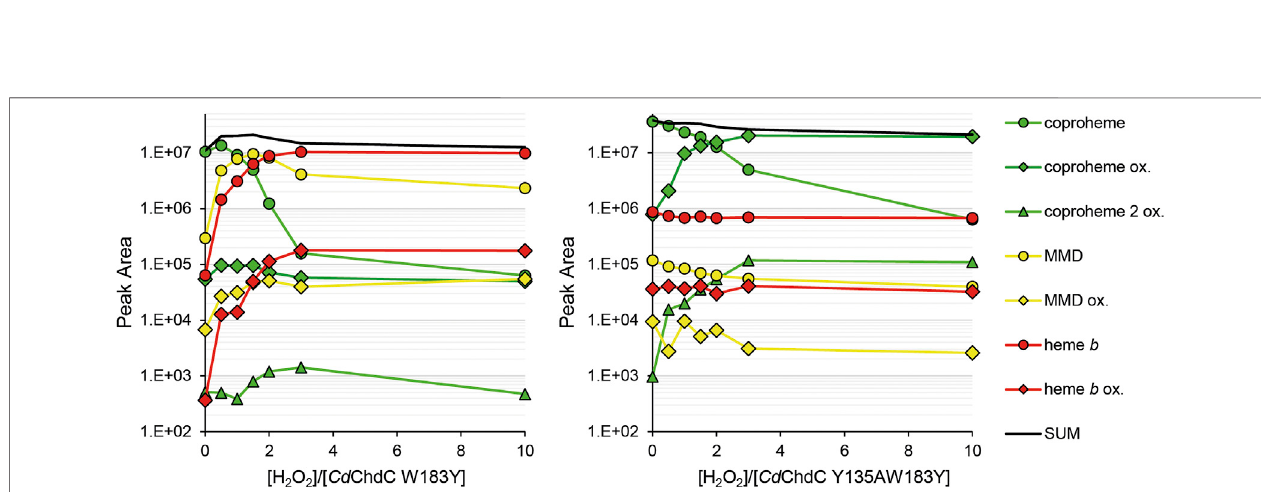
FIGURE 5 | Semi-quanti fi cation of coproheme (green, 708.2 Da), MMD (yellow, 662.2 Da), and heme b (red, 616.2 Da) by mass spectrometry. Single oxidized species oftheporphyrinsareindicatedas diamonds, and double oxidized coprohemeisindicated astriangles. About 10 – 15 µM Cd ChdC W183Y and Y135AW183Y in complex with the coproheme in 50 mM phosphate buffer pH 7 were titrated with sub-equimolar amounts of hydrogen peroxide to monitor the course of the reaction. About 10 µl samples from the one 1 ml reaction mix were drawn and analyzed by mass spectrometry.